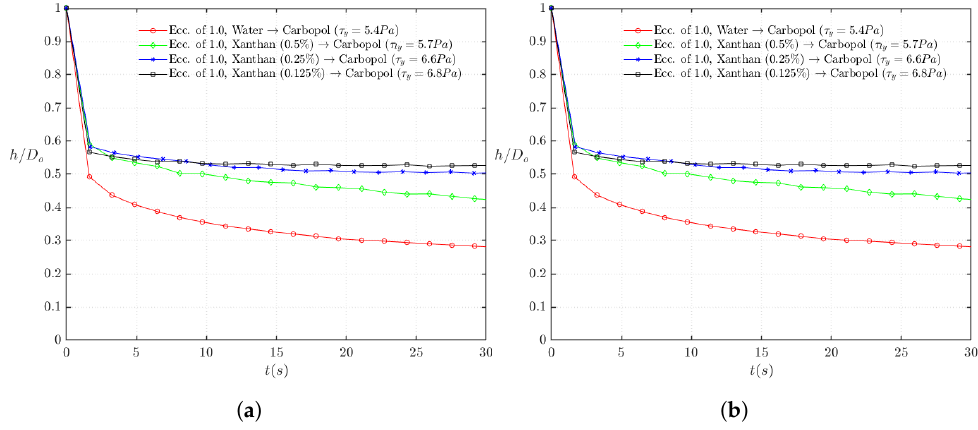
Figure 7. Displacement performance: ( a ) average measured thickness of the Carbopol layer in the fully eccentric annulus and ( b ) computed volumetric efficiency in the fully eccentric annulus.